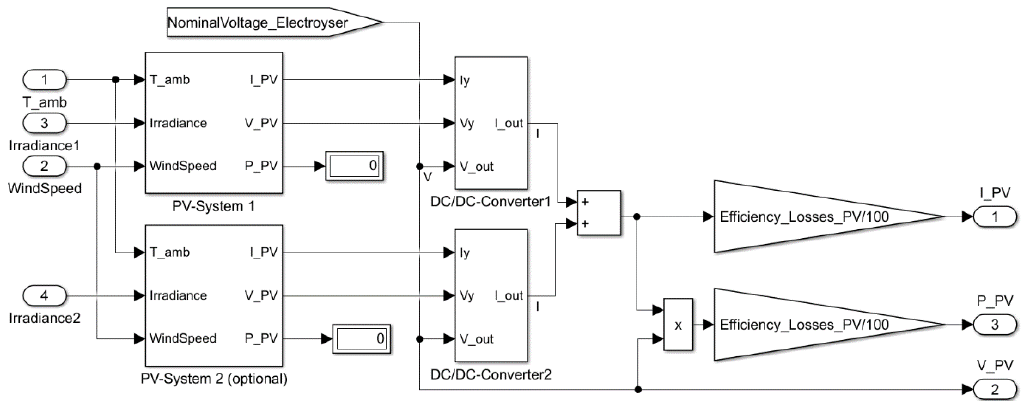
Figure 6 . Layout of PV system in Simulink. Figure 6. Layout of PV system in